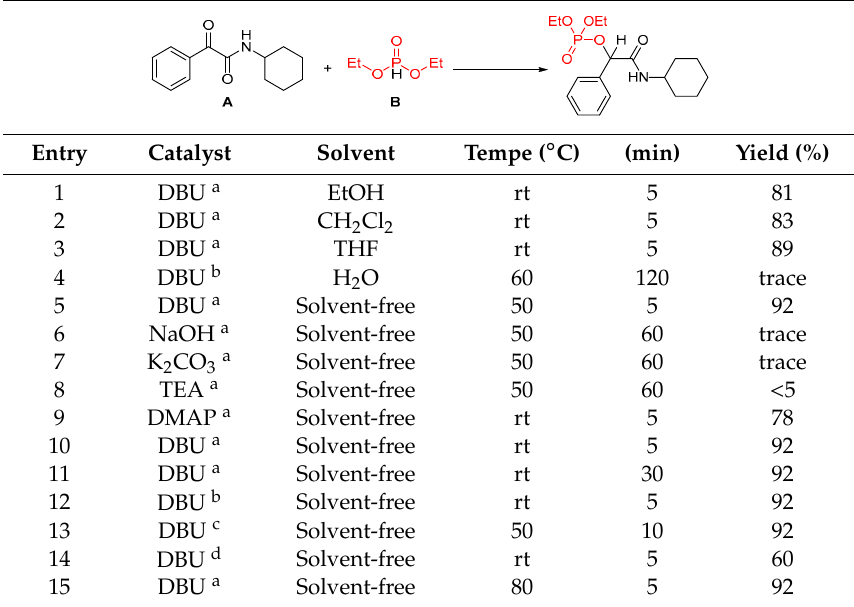
Table 1. Optimization for the reaction conditions (model reaction).